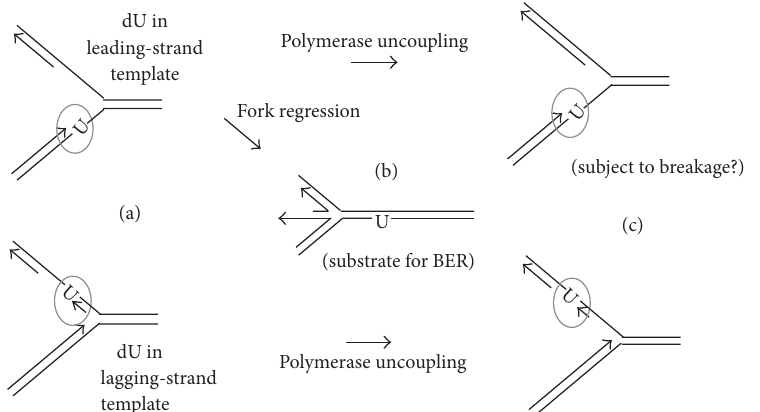
Figure 1: Possible fates of a replicative polymerase stalled at template dU. (a) Archaeal polymerases stall with the nascent 3 󸀠 end 4 nt ahead of the template dU [23]. (b) If the replication fork responds with immediate fork reversal, the dU is restored to its original context, and BER is required for resumption of fork progress. (c) If tight coupling is not preserved, the Mcm helicase and nonstalled polymerase (not drawn) would continue, creating ssDNA region on the stalled template vulnerable to structure- or single-strand-specific nucleases. Arrowheads on DNA strands represent 3 󸀠